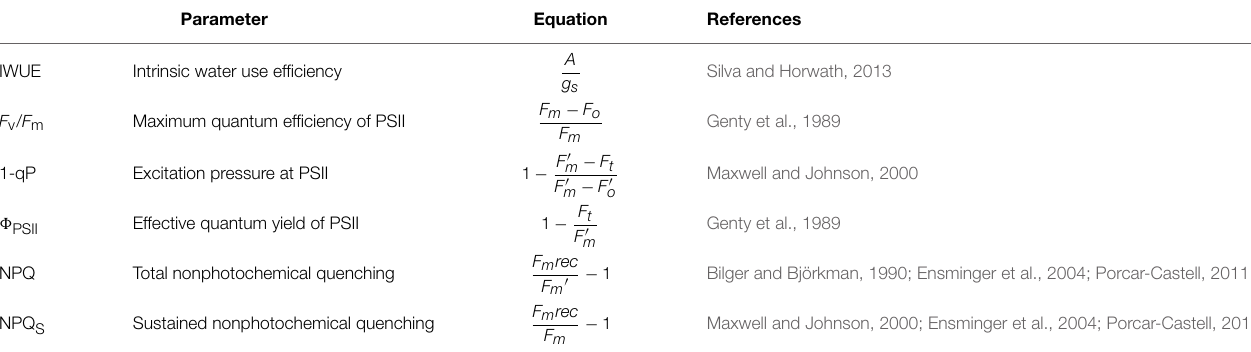
TABLE 2 | Equations for gas exchange and fluorescence